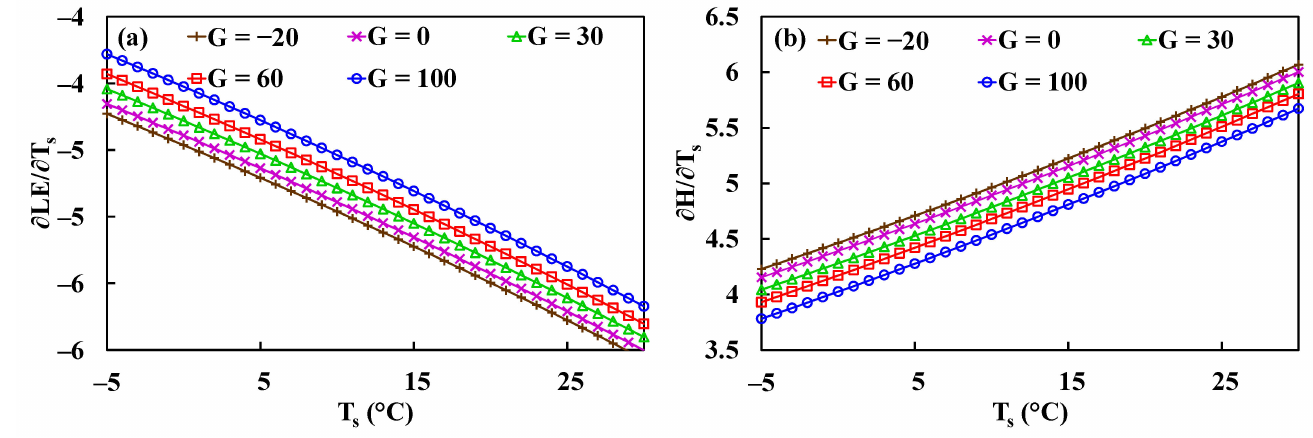
Figure 12. ( a ) ∂ LE/ ∂ T s , ( b ) ∂ H/ ∂ T s as a function of T s under different ground heat